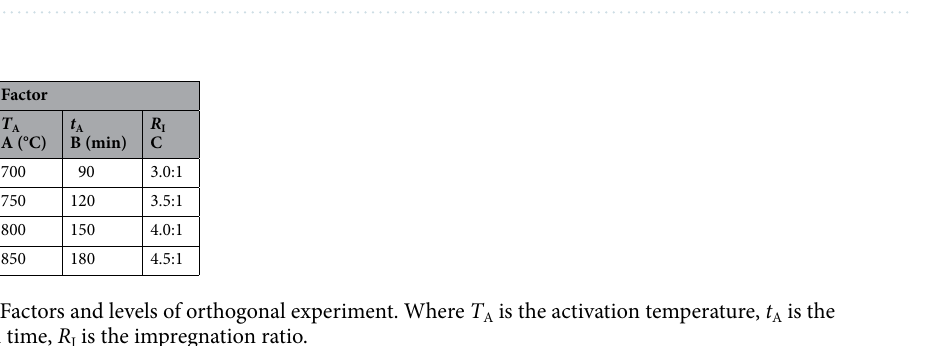
Table 1. Ultimate and proximate analyses of the sargassum. Where M is the moisture, A is the ash, FC is the fixed carbon, V is the volatile.